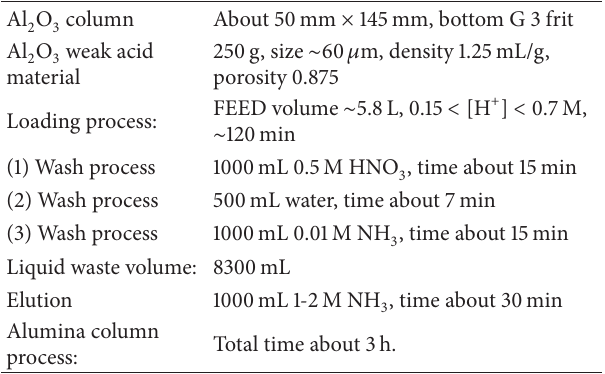
Table 2: Optimal parameters for the alumina column process. Al O column 2 3